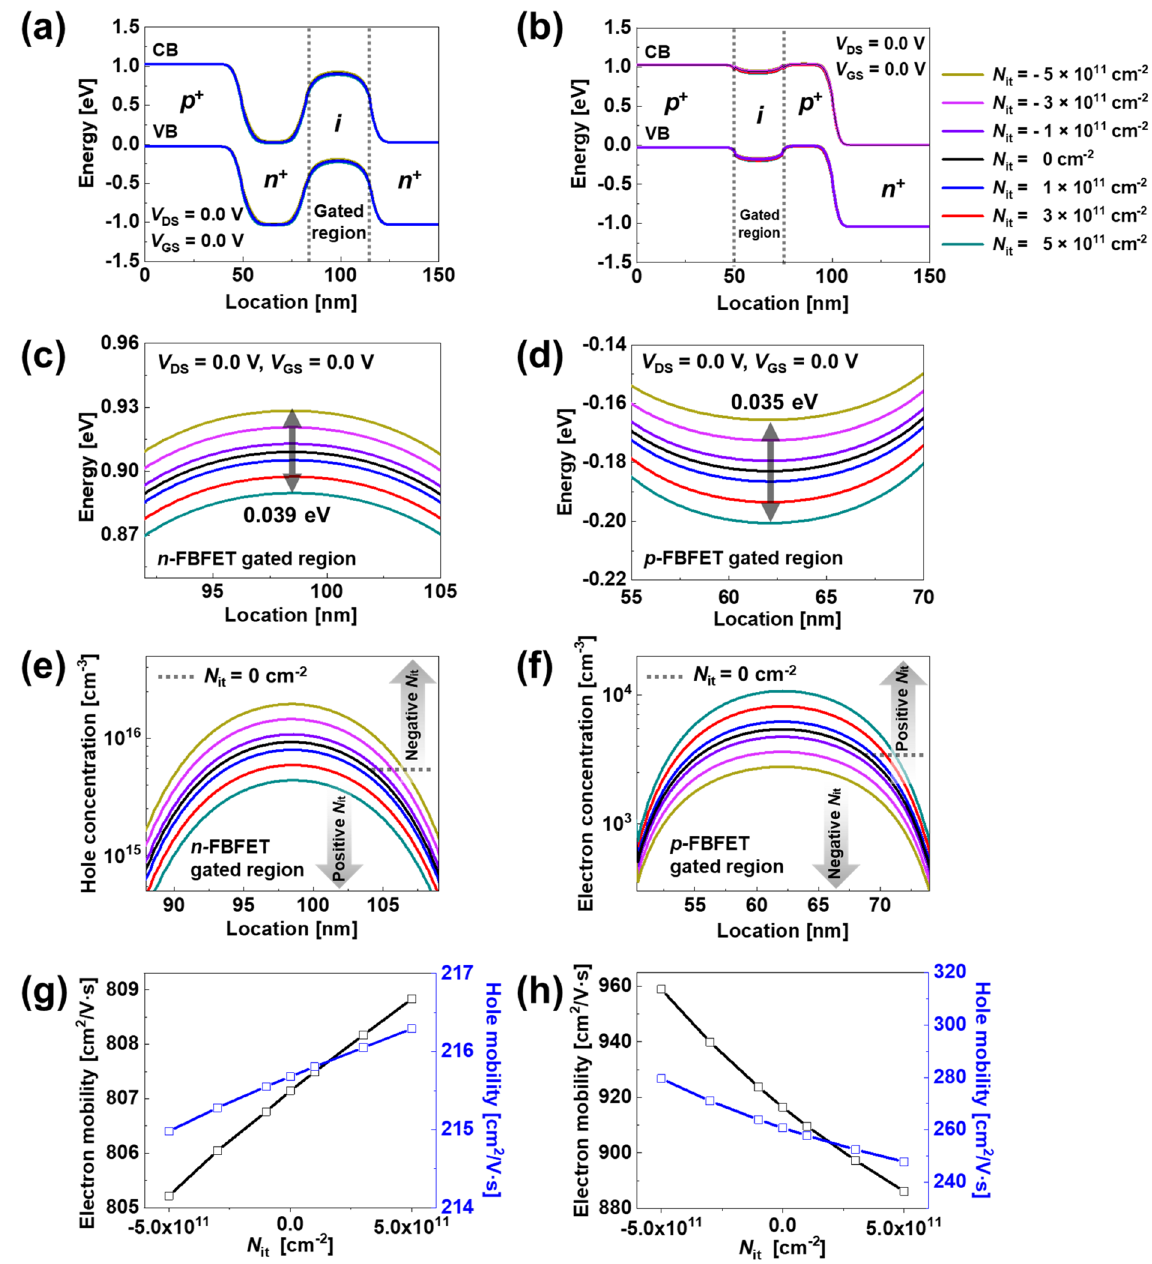
Figure 3. Energy band diagrams of ( a ) n - and ( b ) p -FBFETs at V GS = V DS = 0.0 V. Enlarged view of potential energy of ( c ) n - and ( d ) p -FBFETs in gated region. ( e ) Hole concentration for n -FBFET and ( f ) electron concentration for p -FBFET of gated channel region, respectively. Electron and hole mobility as a function of N it for ( g ) n - and ( h ) p of the channel region. Figure 3c and d show the potential energy differences based on the ITCs in the gated channel region. The reason for potential energy variation of the ITCs is the Coulomb interaction, in which ITCs attract opposite polarity charges 16,17 . Therefore, as N it increases from 0 to − 5 × 10 11 cm −2 , the potential barrier height of the n -FBFET increases, whereas the potential barrier height of the p -FBFET decreases. As N it increases from 0 to + 5 × 10 11 cm −2 , the potential barrier height of the n -FBFET decreases, whereas the potential barrier height of the p -FBFET increases. To confirm the Coulomb interaction in which opposite polarity charges are induced by the ITCs at the inter- face, Fig. 3e and f show the hole and electron concentrations of the gated channel region in the n - and p -FBFETs, respectively; when increasing from N it = 0 cm −2 to N it = − 5 × 10 11 cm −2 in the n -FBFET, the hole concentration increases from 9.25 × 10 15 cm −3 to 1.95 × 10 16 cm −3 , whereas in the p -FBFET, the electron concentration decreases from 5.39 × 10 3 cm −3 to 2.72 × 10 3 cm −3 . When increasing from N it = 0 cm −2 to N it = + 5 × 10 11 cm −2 in the n -FBFET,